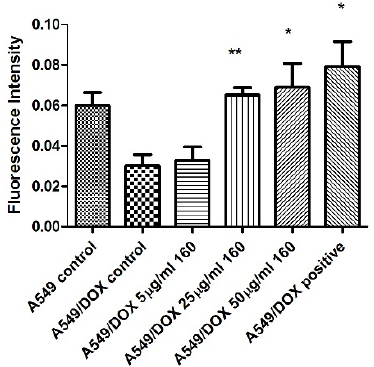
Figure 7. Summary of the fluorescence intensity of intracellular calcein AM in the A549 and A549/DOX cell lines treated with compound 160a and observed using a confocal microscope. DMSO (0.1%) was applied as a vehicle control; 50 μ g/mL verapamil was applied as a positive control. Fluorescence intensity was measured by Image J.